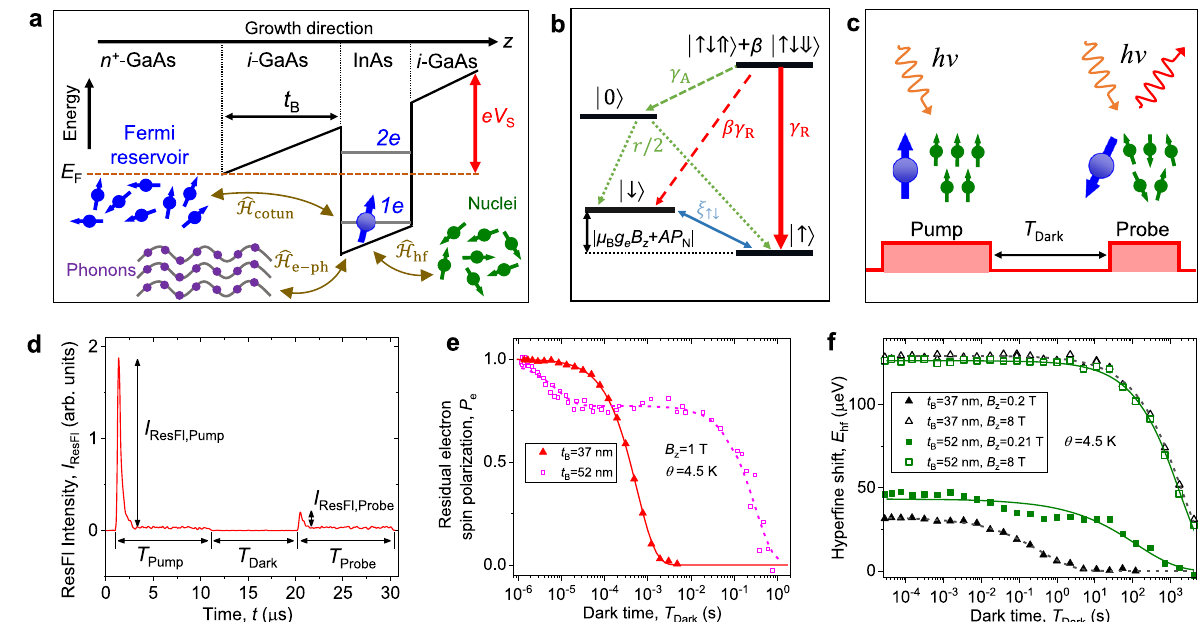
Fig. 1 Electron and nuclear spins in a quantum dot. a Schematic of an InAs quantum dot embedded in a n – i – Schottky diode structure. Electron spin is coupled to nuclei via hyper fi ne interaction ( ^ H hf ) and to phonons ( ^ H e (cid:2) ph ). Tunnel barrier thickness t B controls the cotunneling interaction ( ^ H cotun ). Quantum dot charge state is controlled with bias V S , which tunes the energies of one-electron (1 e ) and two-electron (2 e ) states with respect to Fermi energy E F . b Energy levels of an empty dot 0 j i , electron with spin up ( "j i , s z = + 1/2) or down ( #j i , s z = − 1/2), and a trion "#*j i with hole moment j z = + 3/2, which has a small admixture β ≪ 1 of a trion "#+j i with opposite hole moment j z = − 3/2. Arrow labels show the rates of radiative recombination γ R , Auger recombination γ A , recharging r , and electron spin fl ip ξ ↑↓ . Electron spin splitting is due to Zeeman effect ( μ B g e B z , where g e is electron g -factor and μ B is Bohr magneton) and nuclear hyper fi ne shift E hf ∝ A hf P N . c Timing diagram of a pump-delay-probe experiment where optical excitation is used to initialise and probe the spins of either the electron or nuclei. d Time- resolved resonance fl uorescence (ResFl) in a pump-probe experiment. Resonance fl uorescence pulses of intensities I ResFl,Pump and I ResFl,Probe indicate electron spin pumping and are used to calculate the residual (i.e. relative to initial) electron spin polarisation P e = ( I ResFl,Pump − I ResFl, Probe )/ I ResFl,Pump after time T Dark . e Electron spin decay measured in Coulomb blockade regime as P e ( T Dark ) in diode sample structures with different t B (symbols). Lines show exponential (solid) or rate-equation (dashed) fi tting. f Nuclear spin decay obtained by measuring hyper fi ne shift E hf as a function of dark time T Dark in a pump-delay-probe experiment. Lines show fi tting with stretched exponential